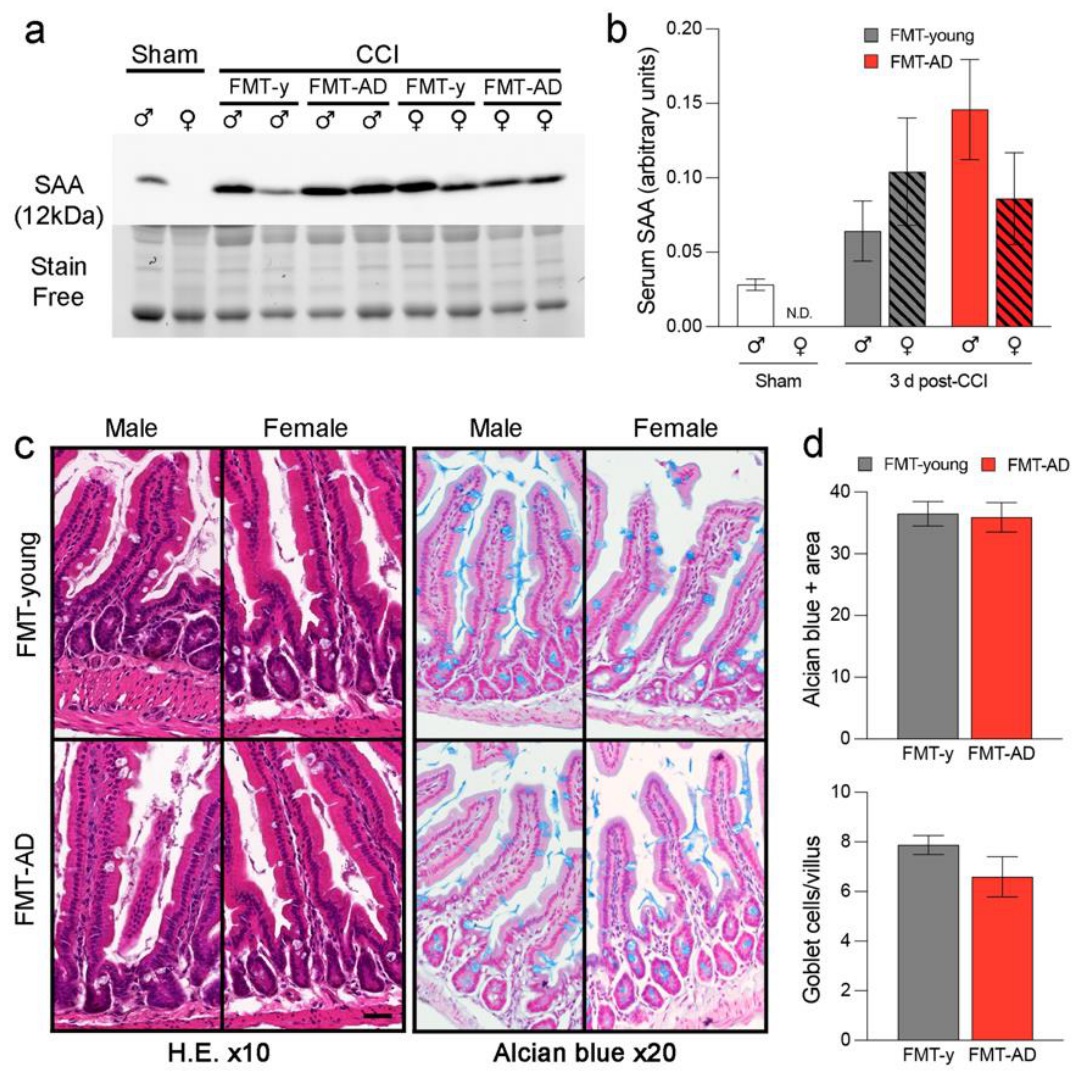
Figure 5. FMT-AD neither induced peripheral inflammation nor caused intestinal damage to recipient mice. ( a ) Western blot showing protein Serum Amyloid A (SAA) levels in the serum from FMT-AD and FMT-young (FMT-y) mice at 3 d post-TBI. ( b ) Quantification of the western blot shows a not statistically significant increase in SAA in the serum of males after FMT-AD compared to FMT-y. ( c ) Representative histology images from intestinal tissue do not show any abnormality between the FMT-y and FMT-AD groups in male or female mice. Left, Hematoxylin and eosin (H.E.) staining; right ( × 10 Objective), Alcian blue staining ( × 20 Objective). ( d ) Densiometric quantification of the Alcian blue positive area and counting the number of goblet cells per villus are not different between FMT-y and FMT-AD groups. Male and female data were combined, since two-way ANOVA showed no sex differences (Alcian blue area, p = 0.429; goblet cells, p = 0.471).